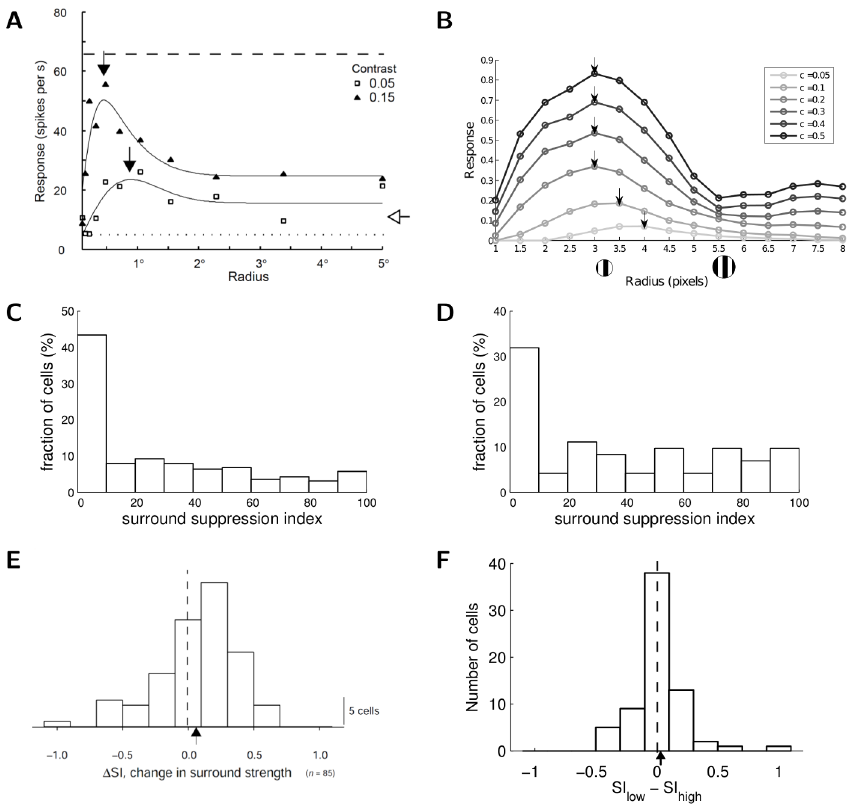
Figure 3. Surround suppression and RF expansion. (A) A plot illustrating that cortical neurons show surround suppression and expansion of CRF size at low contrast (reprinted by permission from Macmillan Publishers Ltd: Nature Neuroscience, Figure 1a from [37]). (B) The size tuning curve of a simulated sparse coding model neuron at various contrast levels (‘‘c’’ stands for contrast, with lighter curves representing lower contrast). The model neuron exhibits two characteristic behaviors reported in the electrophysiology literature: suppression with increasing stimulus size and an increase in the optimal stimulus size with lower contrast. The maximum of each tuning curve is marked by an arrow. (C) Physiologically measured distribution of surround suppression index (SI) in cat V1 (data replotted from [36], Figure 2A), illustrating that most cells do not exhibit significant surround suppression and the SI distribution is relatively uniform among suppressive cells. (D) The SI distribution for the model cells, illustrating the same qualitative properties as the distribution in (C). (E) Distribution of the SI difference ( D SI) between low and high contrast levels in macaque V1 (reprinted by permission from Macmillan Publishers Ltd: Nature Neuroscience, Figure 6b from [37]). The mean difference is 0.06, demonstrating that on average the SI for a cell is contrast invariant. (F) The distribution of D SI for the sparse coding model cells. The mean difference is 0.02, also demonstrating contrast invariance in SI.